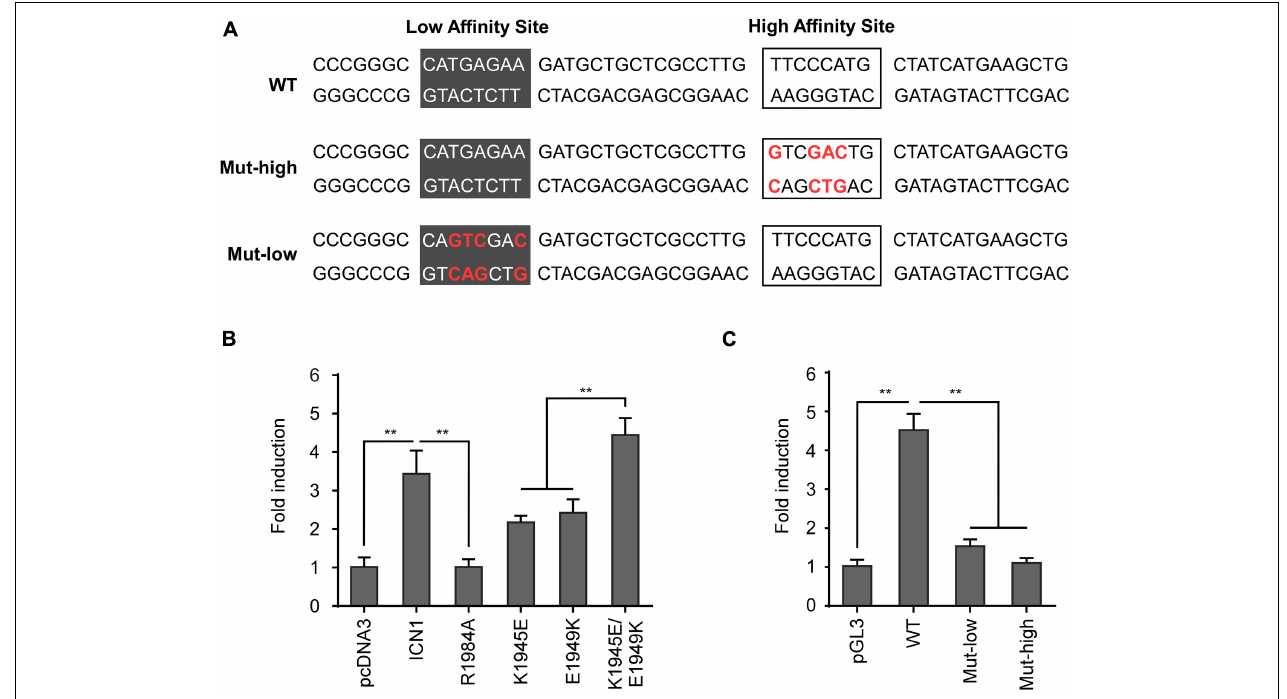
FIGURE 3 | Dimeric Notch1 directly regulates Rag2 transcription. (A) Schematic presentation of the predicted mouse Rag2 SPS. The SPS, within the Rag2 enhancer, consists of a high affinity site (marked by frames) and a low affinity site (marked by dark gray). The high and low affinity sites were mutated as indicated (red), Mut-high and Mut-low, for the following luciferase assays. (B) The Rag2 SPS was constructed to luciferase reporter vector pGL3, then co-transfected with WT ICN1 or indicated mutants. Reporter activities normalized to an empty vector were determined and presented as fold induction. (C) The WT Rag2 SPS or indicated mutants were constructed to luciferase reporter vector pGL3, then co-transfected with WT ICN1. Reporter activities normalized to an empty vector were determined and presented as fold induction. All of the results were shown as the mean of values from triplicate wells ± SD. Data are representative of three independent experiments. ∗∗ p <